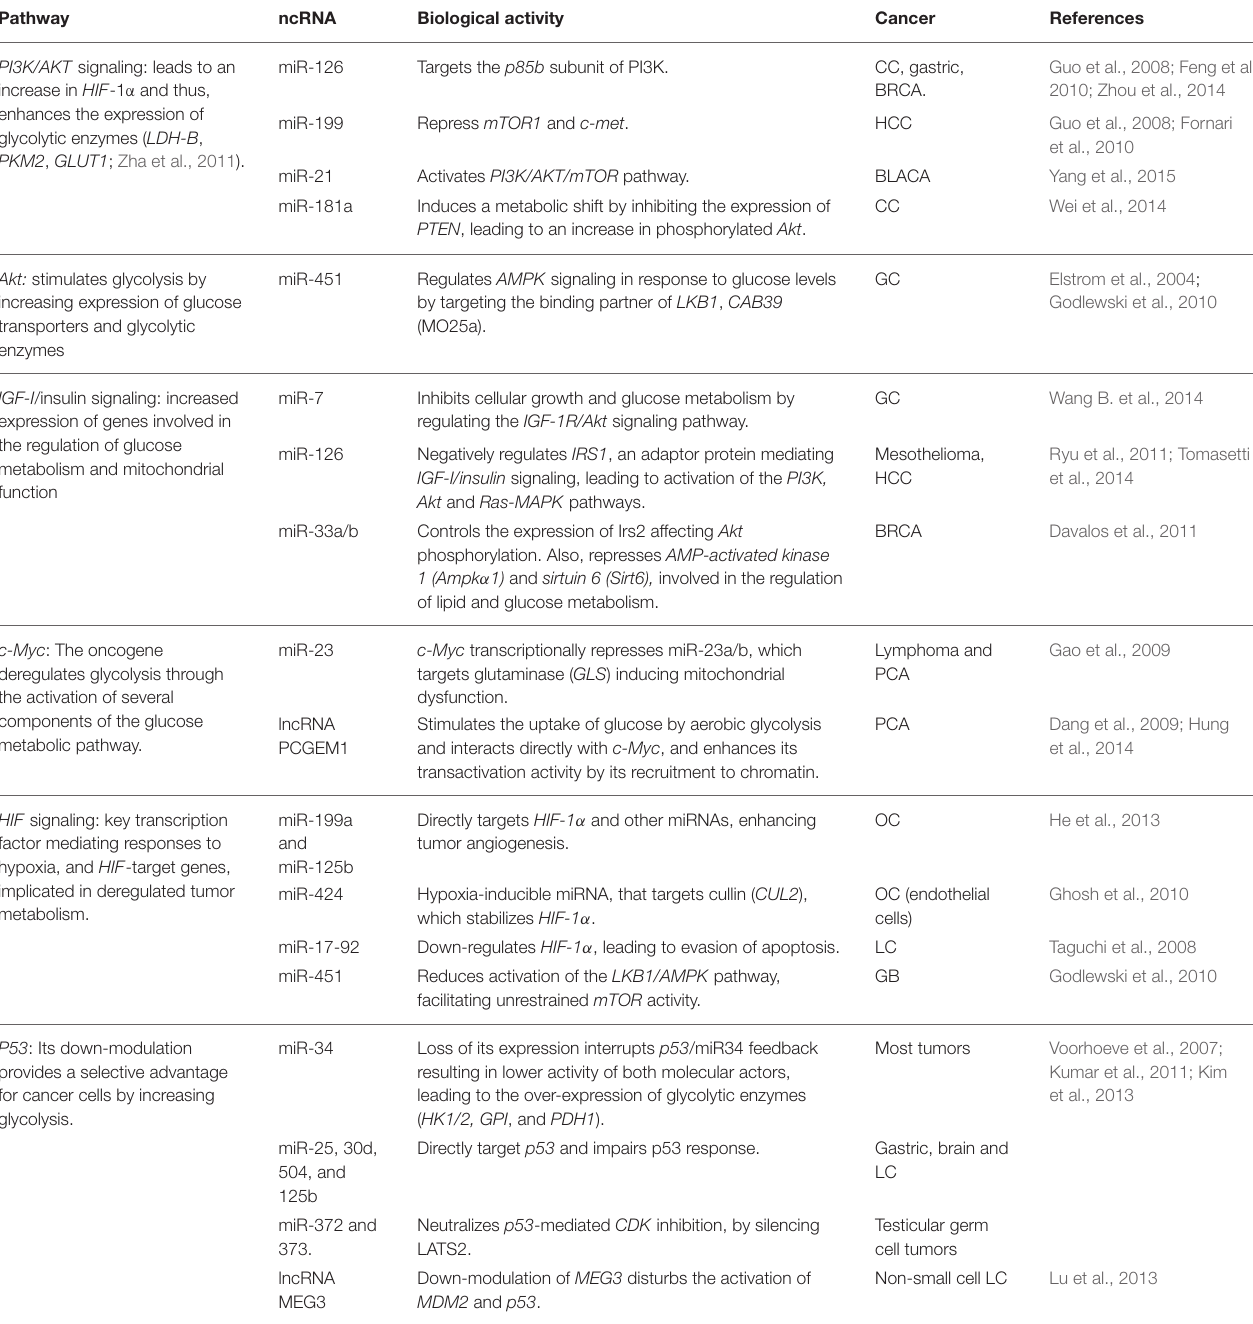
TABLE 1 | ncRNAs and their participation in cancer metabolic processes through oncogenic or tumor suppressor pathways.